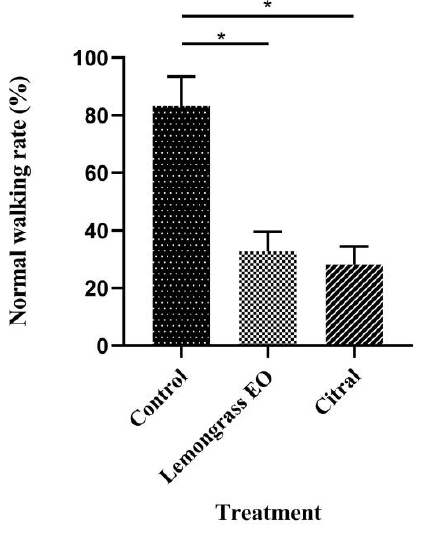
Figure 1. Effect of lemongrass EO and its major constituent on the walking behavior of R. flaviceps workers. Means (±SD) values with * show significant differences ( p < 0.01), according to Tukey’s HSD test.